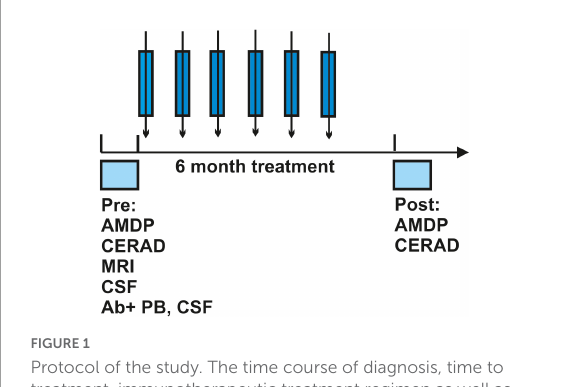
FIGURE1 Protocol of the study. The time course of diagnosis, time to treatment, immunotherapeutic treatment regimen as well as post-evaluation after immunotherapy is depicted. Abbreviations: Ab, antibody; AMDP, Manual for the Assessment and Documentation of Psychopathology in Psychiatry; CERAD, Consortium to Establish a Registry for Alzheimer’s Disease;